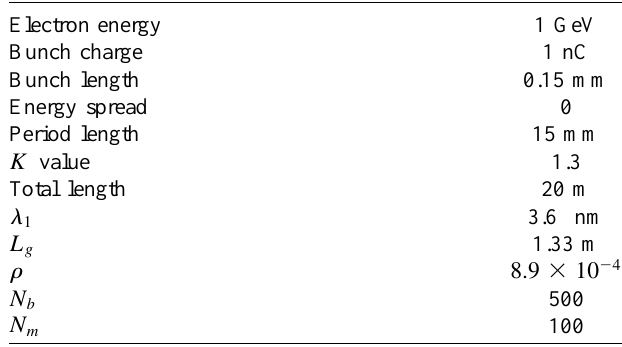
TABLE I. Electron beam and undulator parameters. The num- ber of boxes (cid:2) N b (cid:3) and macroparticles (cid:2) N m (cid:3) used for numerical integration are also